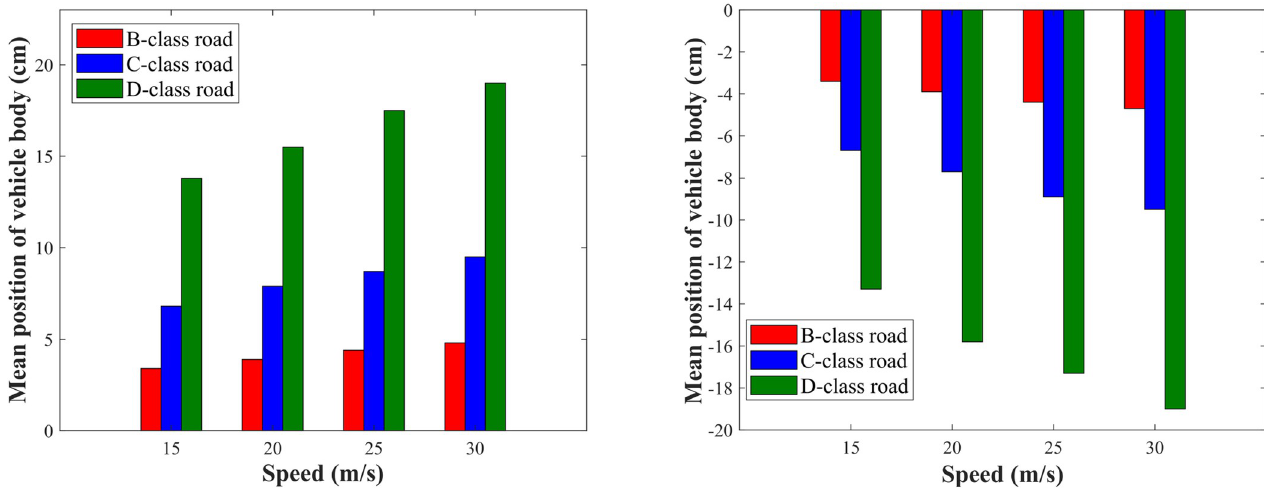
Fig 11. Vehicle body’s mean position with different speeds and road levels. (A) Vehicle body raises; (B) Vehicle body drops.